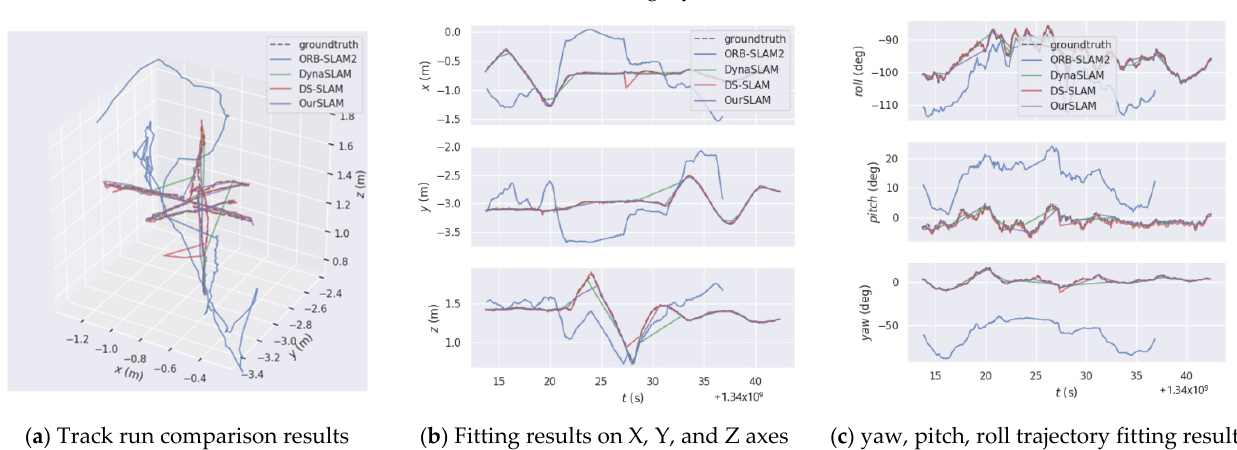
Figure 7. Comparison of ORB-SLAM2, DynaSLAM, DS-SLAM, and OurSLAM trajectory map operation results.